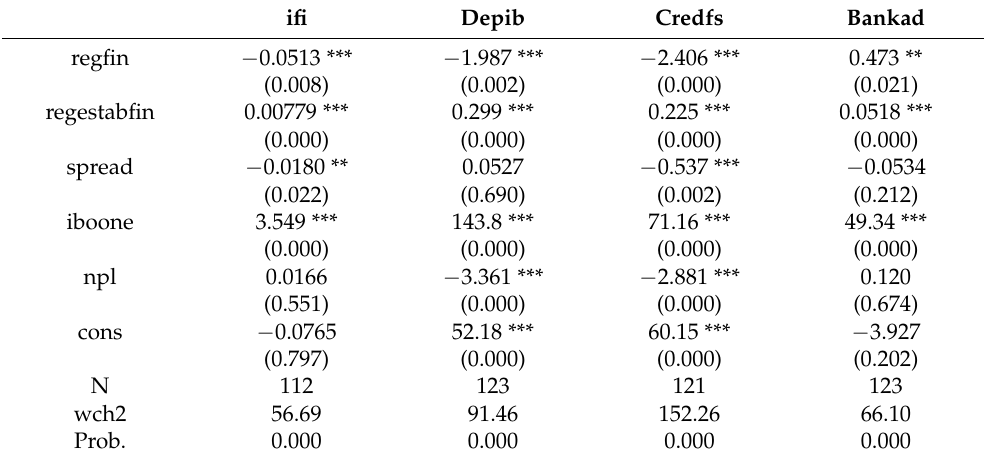
Table 6. Sample of SADC